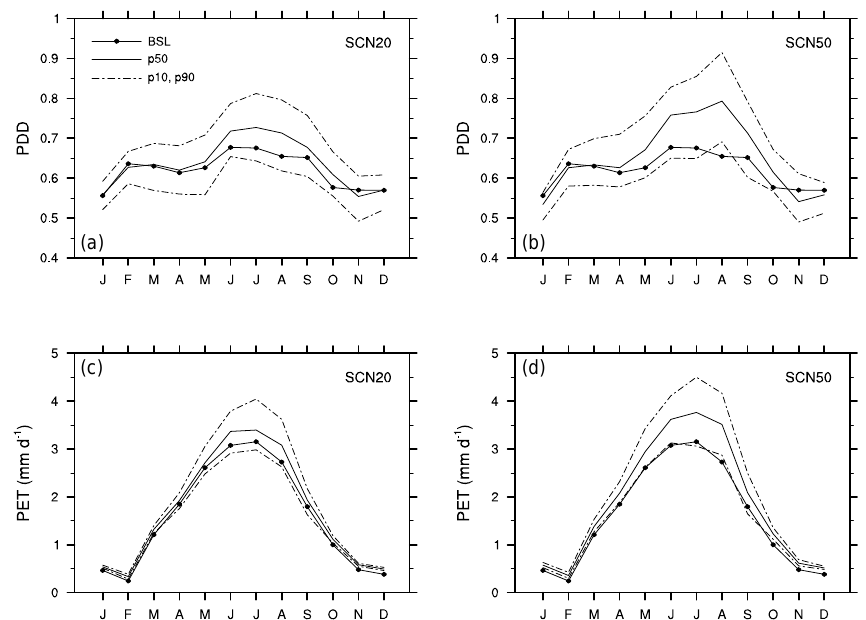
Figure 6. Projected and baseline (BSL) statistics for dry day probability (PDD) and mean daily PET for SCN20 and SCN50 for Thames catchment. For the ensemble projections the central estimate (p50) and upper and lower estimates represented by the 90th (p90) and 10th (p10) percentiles are shown.